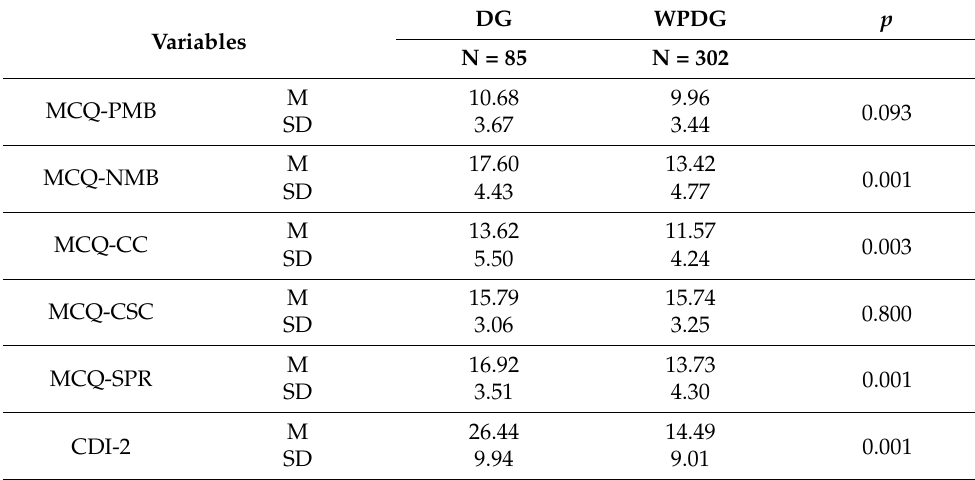
Table 2. Descriptive characteristics of the results of MCQ-A and CDI-2